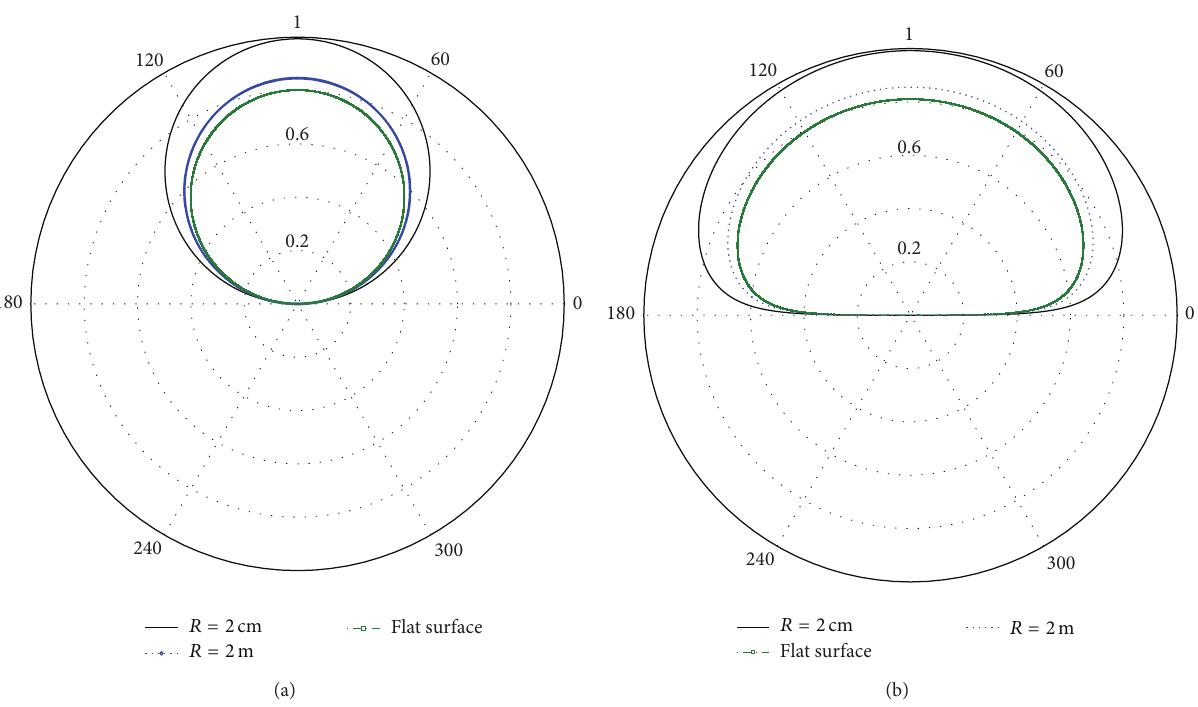
Figure 7: (a) Normalized 𝐻 -plane ( 𝜑 = 90 ∘ , 270 ∘ ) and (b) normalized 𝐸 -plane ( 𝜑 = 0 ∘ , 180 ∘ ) in dB at radii of curvature 2cm, 2 m and flat surface. “Epsilam-10 ceramic-filled Teflon substrate.”